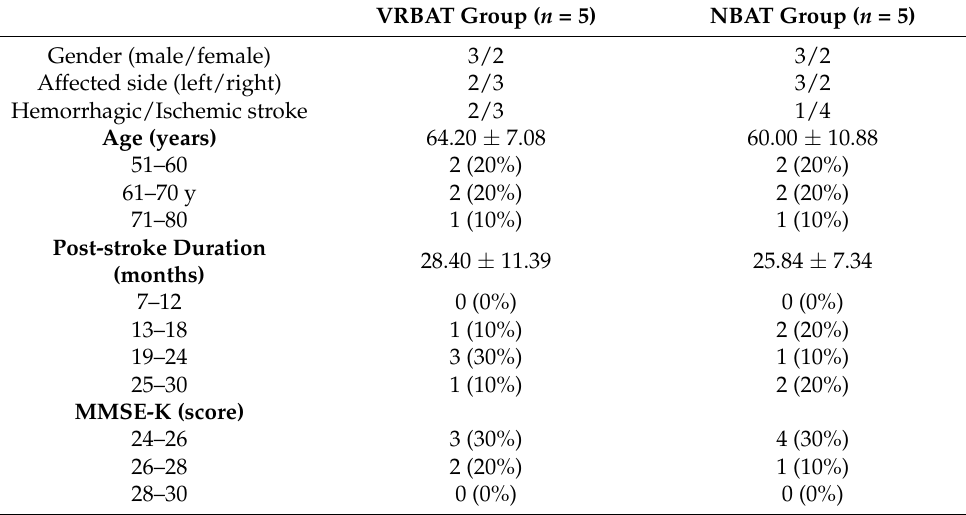
Table 1. Demographic and clinical characteristics of the study participants.